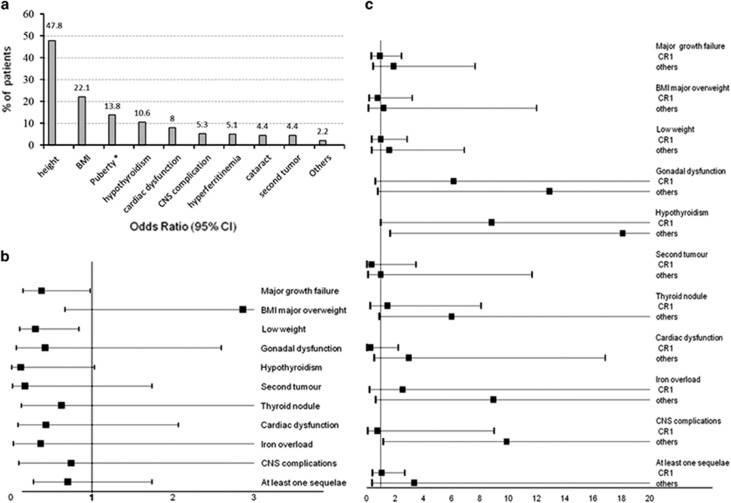
Occurrence of late effects. (a) in the overall population. Height, BMI, gonadal function, and thyroid function are the most frequent sequelae in our population of long term survivors of acute leukemia during infancy (<1 year). Adult height was assessable in 24 patients and revealed a median growth failure of −1.01 SDS [−5.05–1.75] that is, a final height for girls of 158 cm [140–169] and 168 cm [114–185] for boys.* Puberty was assessable in 58 patients. Precocious puberty was diagnosed in one (1.7%) patient and hypogonadism in eight (13.8%) patients. One second tumor was a thyroid malignancy, whereas nine (8%) patients presented with thyroid nodules. Central Nervous System complications consisted of seizures in three (2.7%) patients and hemiparesis, memory problems, and not-specified in one patient each (0.9%). Other complications included one case of hepatic viral transmission (0.9%) and two cases of alopecia (1.7%). There were no cases of diabetes, osteonecrosis, or metabolic syndrome (only 19 adults were assessed for the occurrence of a metabolic syndrome). Concerning fertility, three women gave birth. (b) Forest plot (multiple logistic regression analyses) according to age at diagnosis (six months). Age>6 months was significantly associated with a lower incidence of major growth failure (OR=0.38, P=0.046) and low weight (OR=0.3, P=0.022). (c) Forest plot according to HSCT in CR1 (= CR1) or after (= others). No impact of HSCT performed in CR1 (= CR1) was shown, whereas HSCT occurring after CR1 (=others) significantly increased the risk of hypothyroidism (OR=18.09, P=0.018) and CNS complications (OR=9.89, P=0.036). For multivariate analyses, covariates found to be significant (at a threshold of 0.05) by univariate analysis for at least one sequela were included in multiple logistic regression models. Each model was generated using its non-standardized ß-coefficient and the significance of the association set at P<0.05.